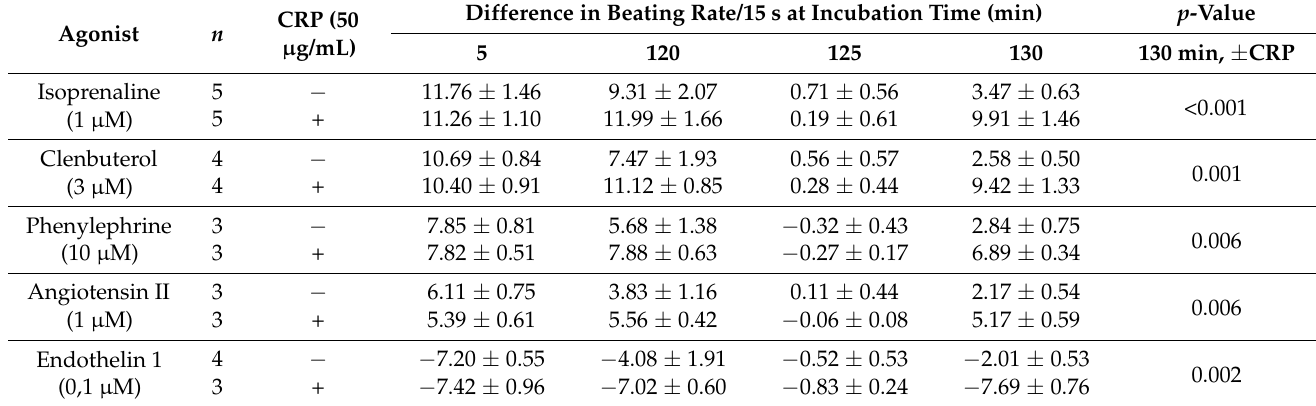
Table 1. Effect of CRP on the beating rate of neonatal rat cardiomyocytes stimulated with agonists against GPCRs. The data show the increase or decrease in the beating rate as mean ± standard deviation of the rat